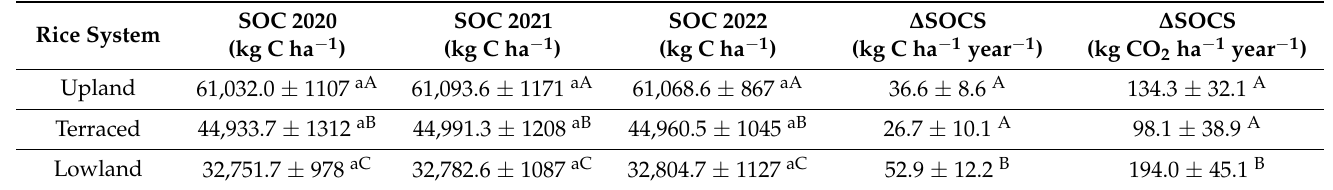
Table 2. SOC stock at 0–30 cm, and the SOC sequestration rate from 2020–2022 (mean ± standard